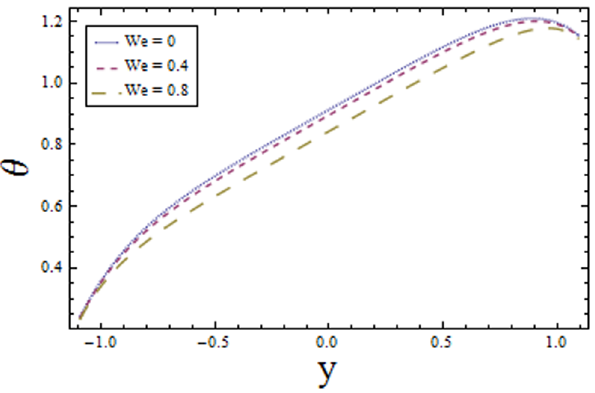
Figure 7. Plot of temperature h for Weissenberg number We with E ~ 0 : 1 , t ~ 0 : 01 , x ~ 0 : 2 , ª 1 ~ 4 , ª 2 ~ 6 , E 1 ~ 0 : 4 , E 2 ~ 0 : 2 , E 3 ~ 0 : 3 , m 1 ~ 2 , n ~ 0 : 4 , Br ~ 1 and m ~ 0 : 04